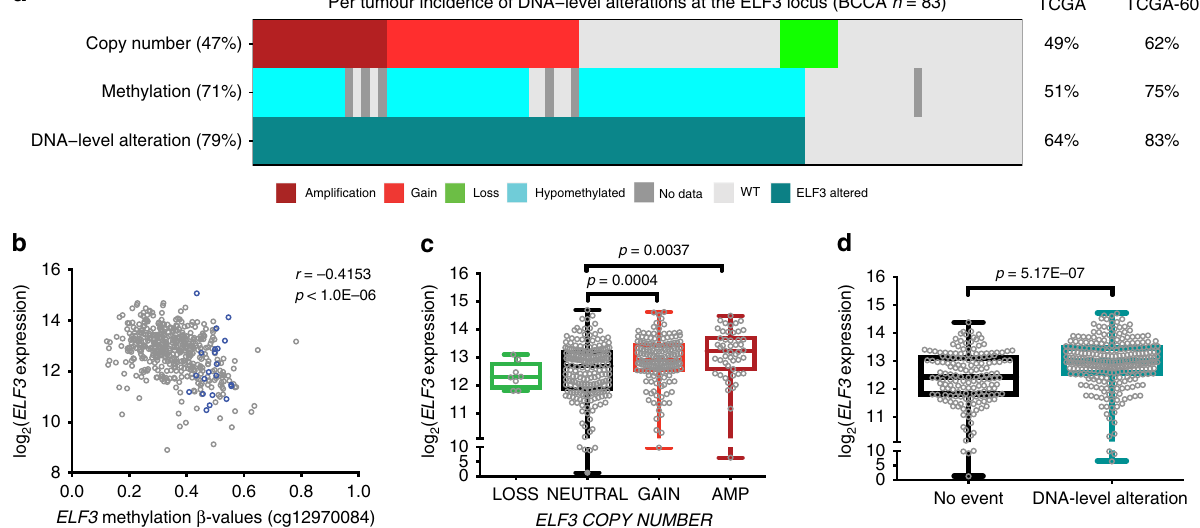
Fig. 2 Genetic and epigenetic alterations at the ELF3 locus. a Case-by-case representation of ELF3 locus deregulation in the BCCA data set ( n = 83 pairs) by genetic and epigenetic events. The frequencies of copy number gain or ampli fi cation, and promoter hypomethylation are indicated, as well as the cumulative frequency of ELF3 DNA-level alterations in the BCCA data set. These frequencies are also summarized to the right of the plot for the TCGA ( n = 420) and TCGA-60 ( n = 252) data sets (TCGA cases with ≥ 60% tumor cellularity, see Methods). b Scatter plot of ELF3 promoter methylation ( x axis) and log 2 ELF3 expression ( y axis) across 452 LUAD (gray) and 21 non-malignant lung (blue) samples (Spearman ’ s correlation). c Log 2 ELF3 expression as a function of DNA copy number alteration in LUAD ( n = 420). ELF3 expression is increased with activating events (Mann – Whitney U test). d Comparison of log 2 ELF3 expression between LUAD with gain and/or promoter hypomethylation (blue) compared with those without (black) ( n = 420, Mann – Whitney U test). In all box and whisker plots, center line represents the median, box bounds indicate the 25th and 75th percentiles, and whiskers extend from minimum to maximum. LUAD = lung adenocarcinoma, AMP = ampli fi